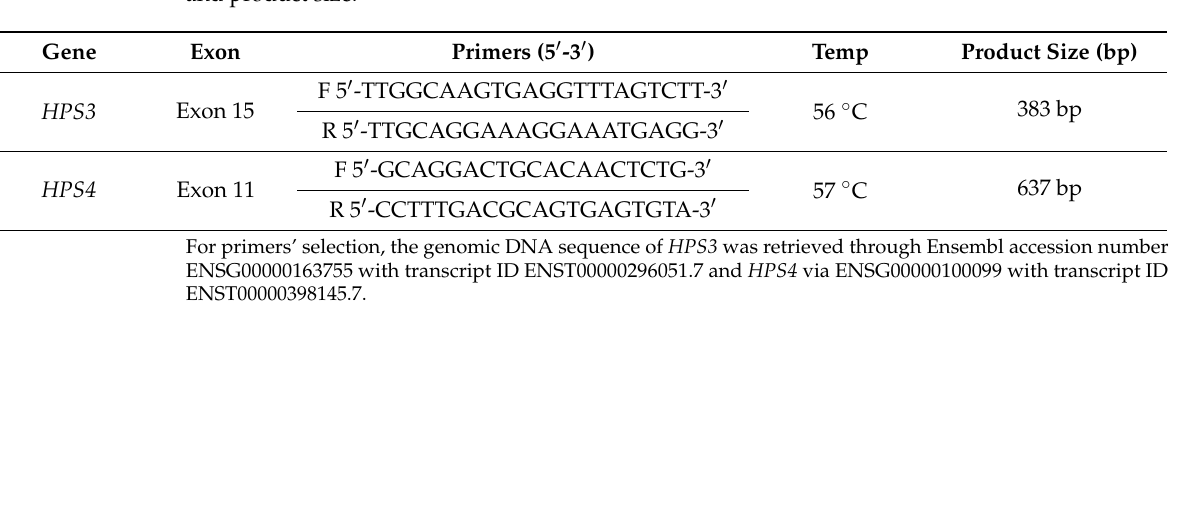
Table 1. Primers designed by Primer3plus, written with gene name, exon no, annealing temperature, and product